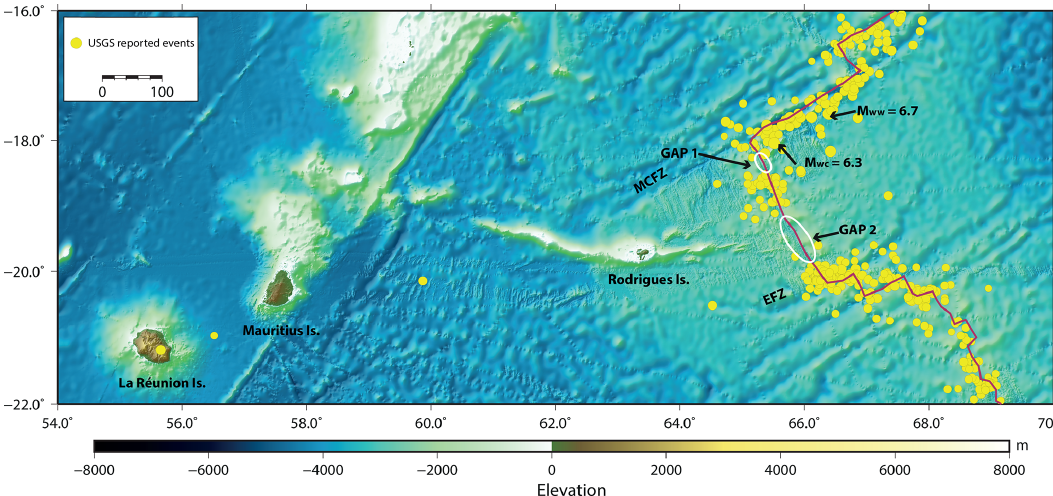
Figure 1. Tectonic setting of Rodrigues Ridge–Central Indian Ridge (CIR) region. The ridge axis is shown by a solid line (red). Event locations from USGS catalogue (January 2000–August 2020) are shown in yellow. MCFZ stands for Marie-Celeste fracture zone, and EFZ stands for Egeria fracture zone. The gaps in seismicity (GAP 1 and GAP 2) along the section of CIR between MCFZ and EFZ have been marked by white ellipses.